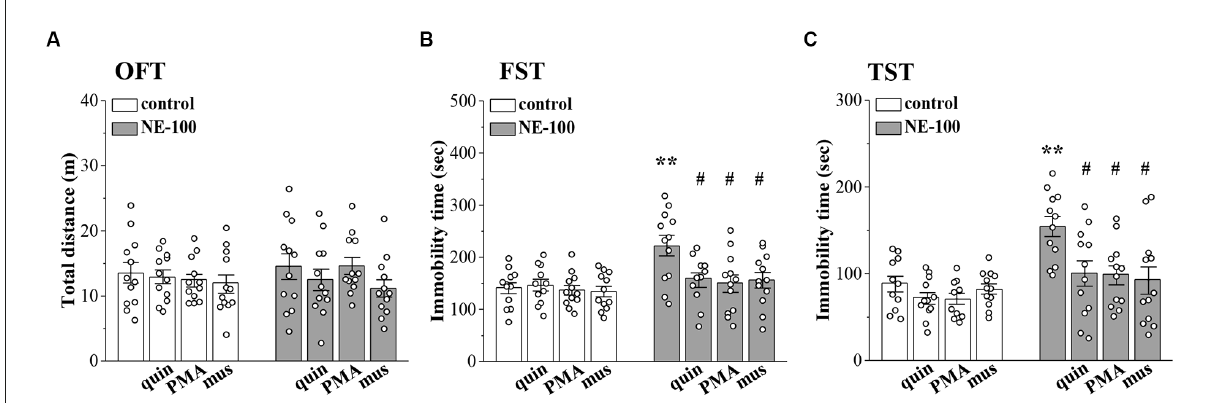
FIGURE6 Involvement of impaired LTD in the NAc in depressive-like behaviors. (A – C) Bar graphs show the distance traveled in OFT, and the immobility time in FST and in TST of control mice, NE-100 mice, and mice treated with NAc-injection of quinpirole (quin), PMA, or muscimol (mus). ** p < 0.01